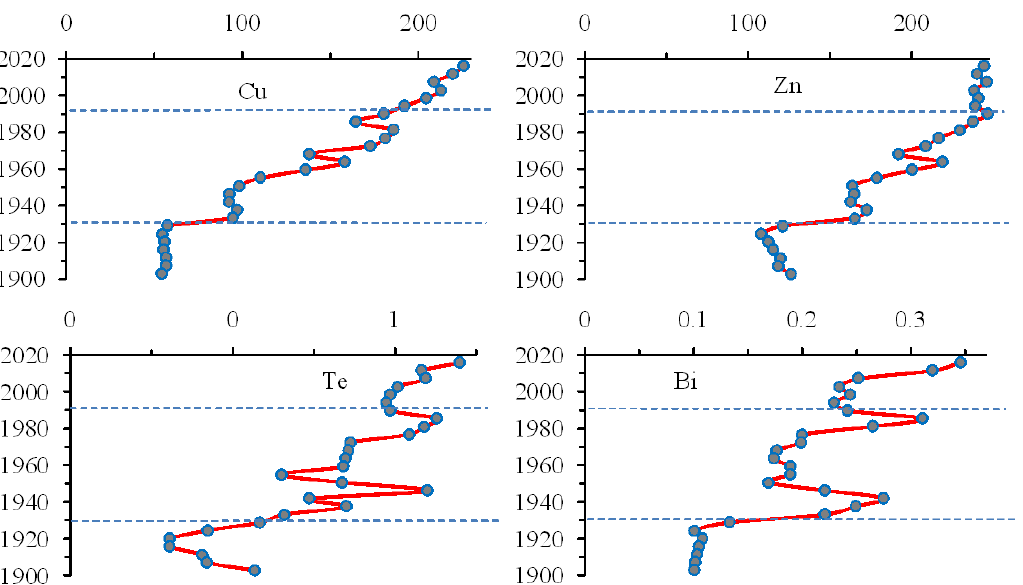
Figure 11. Vertical distribution of the content (µg/g) of Cu, Zn, Te, and Bi in the sediments of Lake Bolshoy Vudjavr.